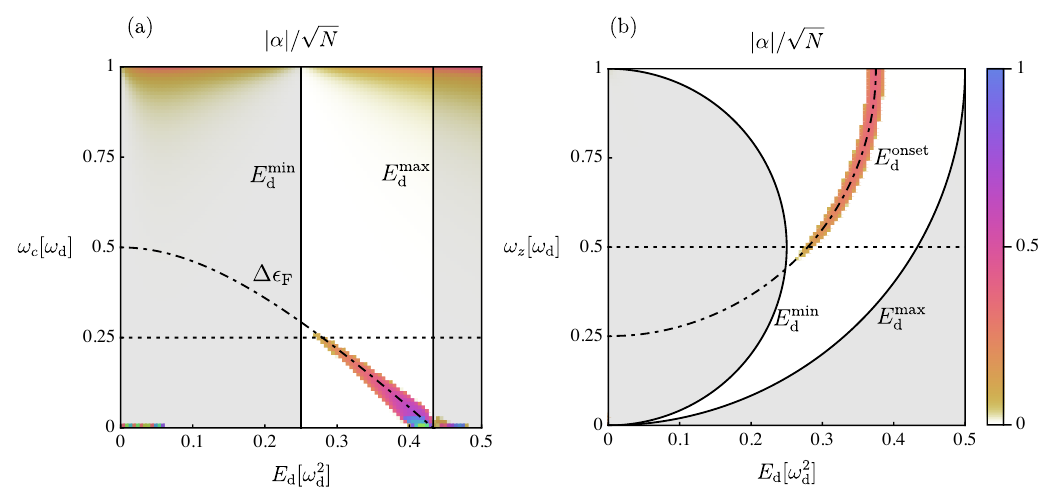
Figure 4: The magnitude of the photonic steady state α as a function of the driving field strength E , the cavity frequency ω (a) and the two-level energy spacing ω d c / 24, such that the Floquet-assisted superradiant The coupling is small with λ = ω d phase (FSP) appears only close to resonance between the cavity frequency ω the Floquet energy difference ∆ ε 0 , indicated by dot-dashed lines at E onset F shaded areas are regimes in which no population inversion of Floquet states occurs. They are bounded by E min and E max . The dotted lines indicate the values of ω d d ω of the other subfigure, z